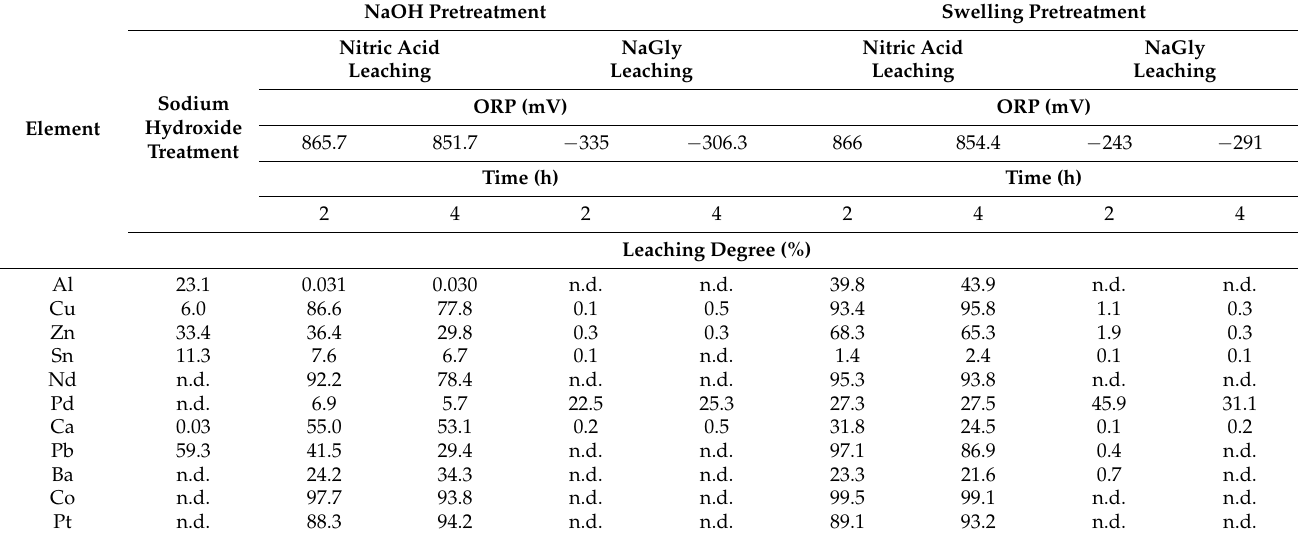
Table 6. Influence of pretreatments on two-pronged (Nitric–NaGly) leaching. NaOH Pretreatment Swelling Pretreatment